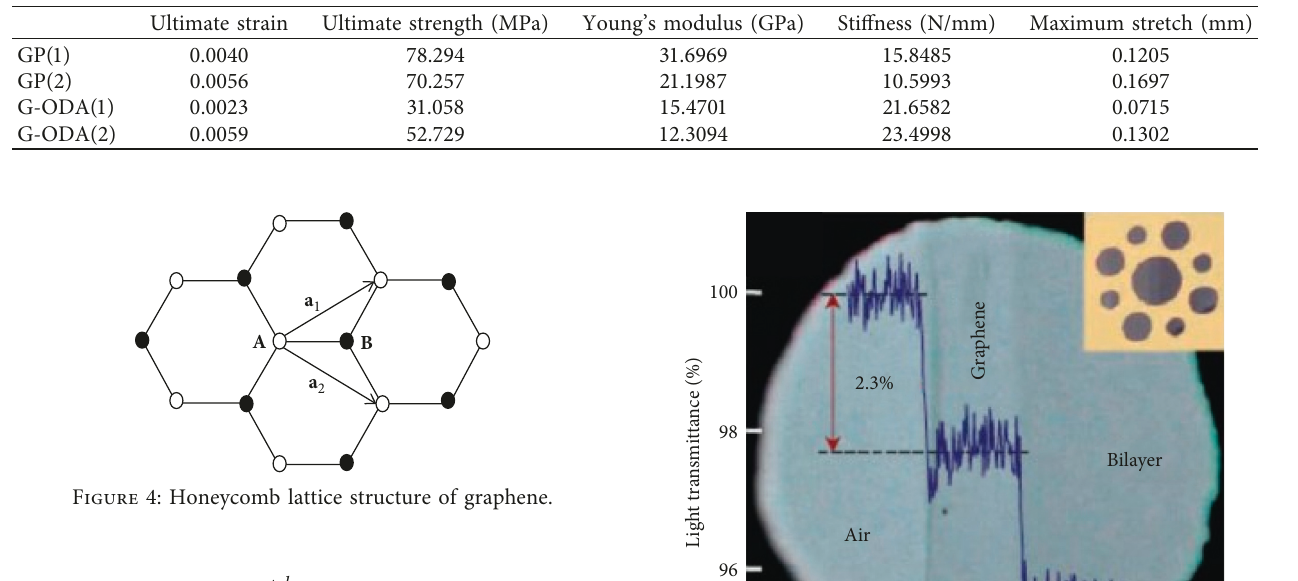
Table 2: Tensile test results of GP and G-ODA strips.